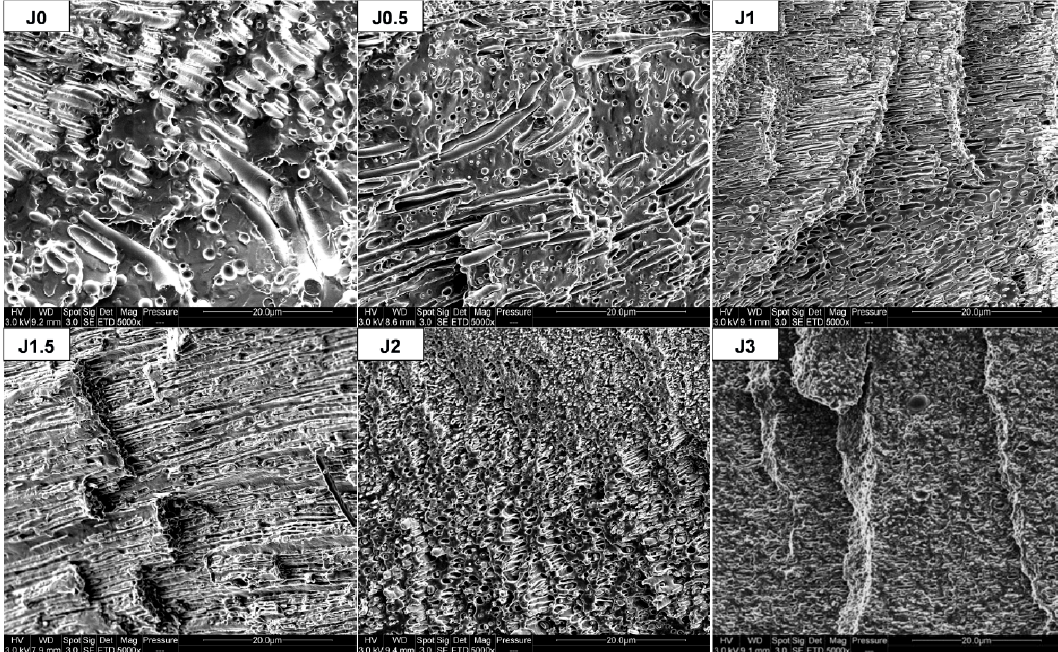
Figure 7. SEM observations of FDM dog bone shaped samples in longitudinal direction.